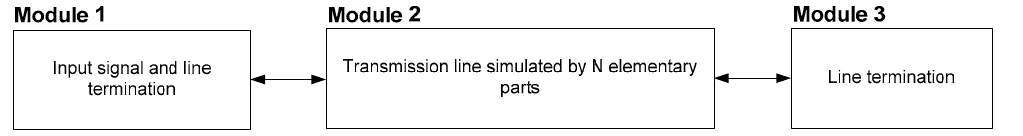
Figure 8. An overview of an LTSpice simulation scheme.